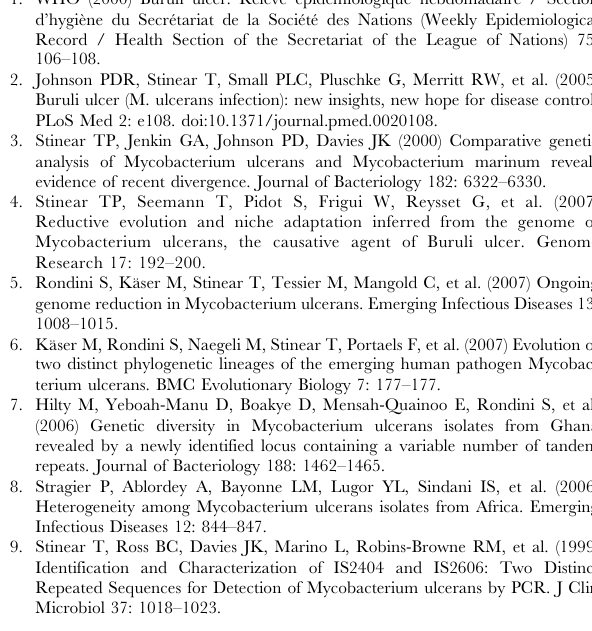
Figure S3 Empirically determined MAQ consensus quality scores improved the accuracy of SNP calls in M. ulcerans Solexa